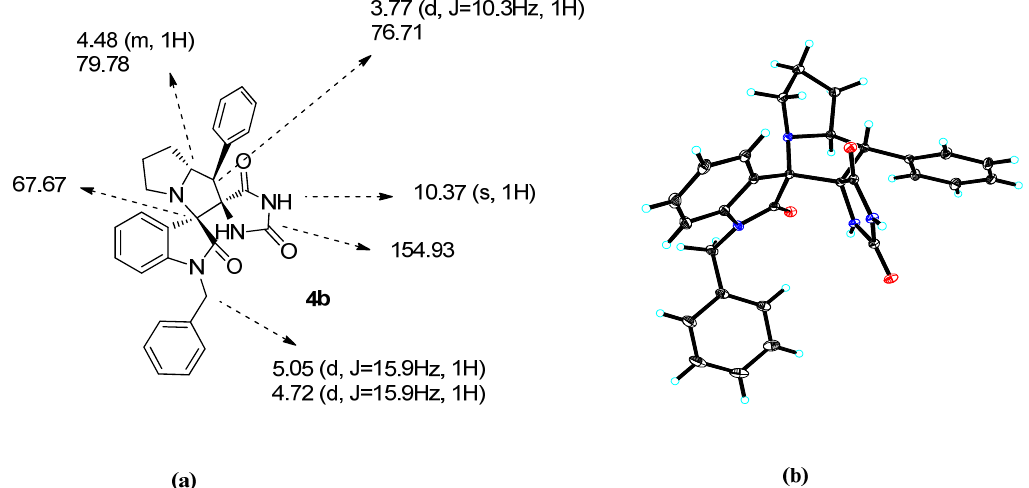
Figure 1. ( a ) Selected 1 H- and 13 C-NMR chemical shifts of 4b . ( b ) Single crystal X-ray diffraction study of compound 4b